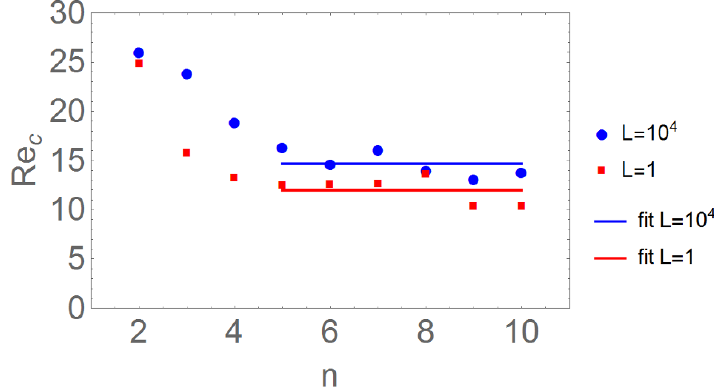
Figure 13 . The critical Reynolds number of a three dimensional (cid:13)ow vs. the initial wave number n . In black the numerical results for M (cid:24) 0 : 01 (cid:28) 1 ( L = 10 4 ) resulting in Re c = 15 : 2 (cid:6) 2 : 6 ignoring the (cid:12)rst two points on the left. In blue the numerical results for M (cid:24) 100 (cid:29) 1 ( L = 1) resulting in Re c = 12 : 2 (cid:6) 1 : 1 ignoring the two leftmost